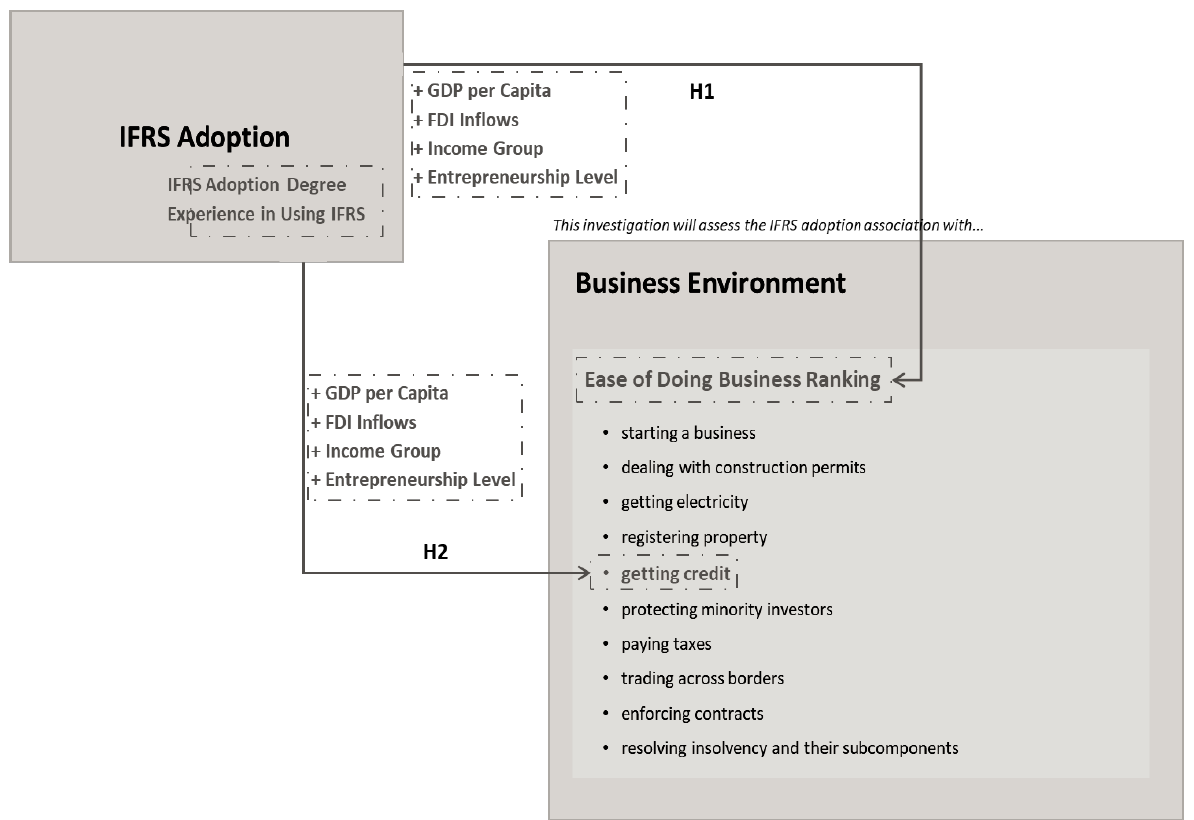
Figure 2. Conceptual framework including the research variables . Source: The authors.